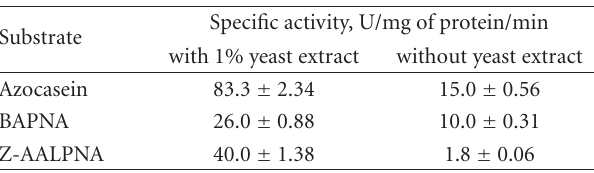
Table 3: Total exoproteinase activity of R. solani grown on medium without and with yeast